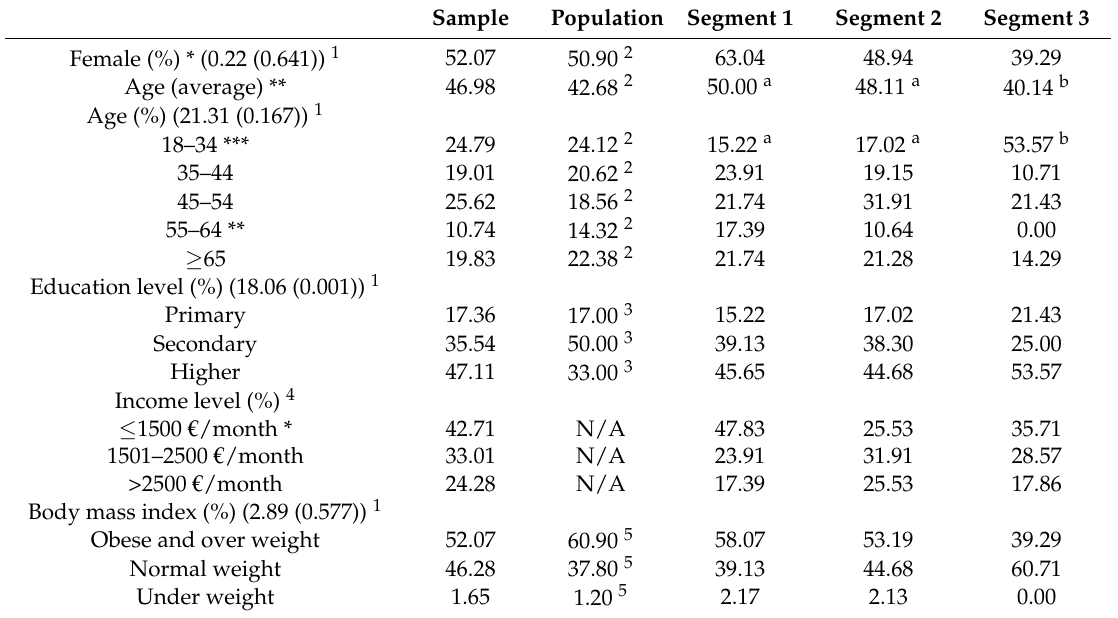
Table 2. Sociodemographic and economics characteristics and Body Mass